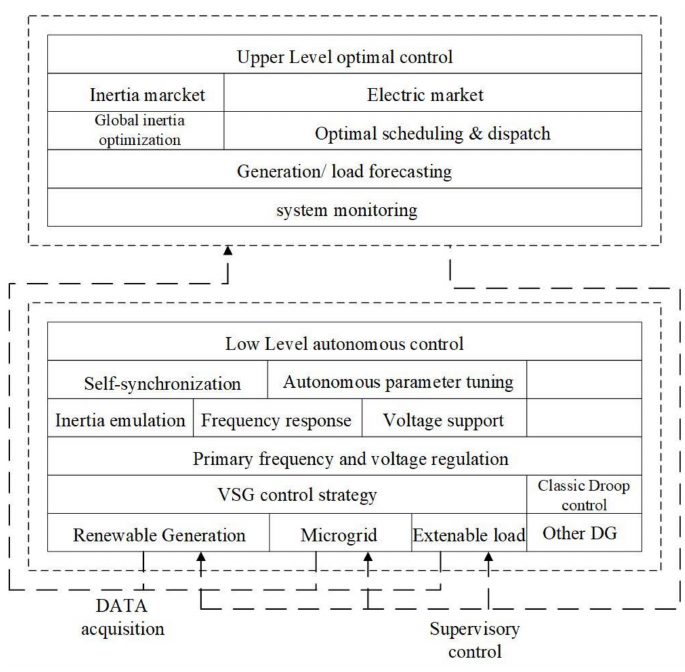
Figure 14. Diagram of VSG-enabled system